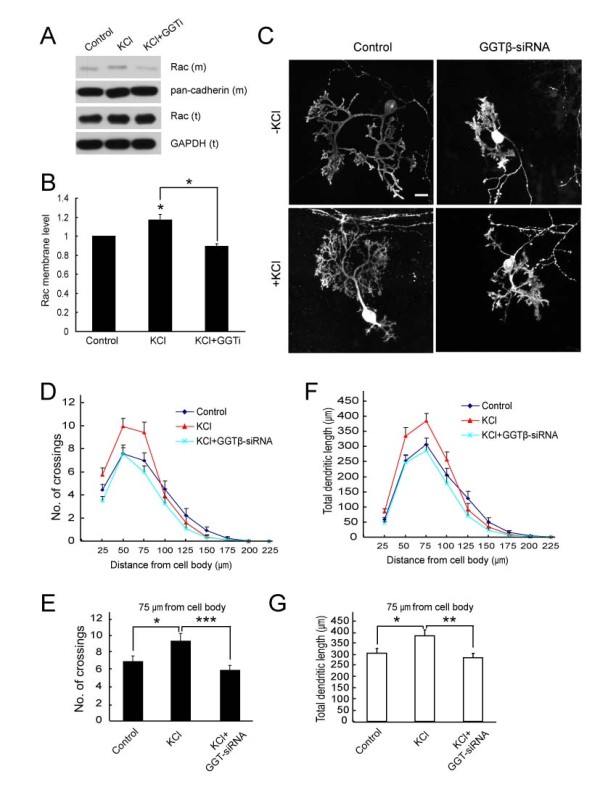
Effect of GGT-siRNA on high K+-induced Purkinje cell dendrite development. A) Rat cerebellar slices at DIV2 were pre-treated with GGTi-2147 (2.5 μM) or vehicle DMSO for 45 min, followed by the treatment with KCl (10 mM) for 2 hr. Membrane fractions were separated and subjected to IB with indicated antibodies. B) Quantification for the levels of membrane Rac, Rac (m). Data were shown as means ± SEM from three independent experiments. *P < 0.05. Student's t test. C) Representative images of Purkinje cells transfected with pSUPER or pSUPER-GGTβ-siRNA, without or with 10 mM KCl treatments. D, E) Quantification for the number of crossings at indicated distances from soma. F) Quantification for total dendritic length between neighboring circles. G) Total dendritic length between the circle of 50 and 75 μm. Data are shown as means ± SEM (n = 39 for control; n = 47 for GGT-siRNA; n = 36 for KCl; n = 34 for KCl with GGT-siRNA). N.S. P > 0.05; *P < 0.05; **P < 0.01; ***P < 0.001. Student's t test. Scale bar = 20 μm.